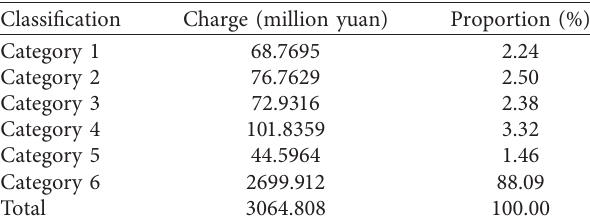
Table 7: The proportion of traffic and tolls of all kinds of goods vehicles in the whole road